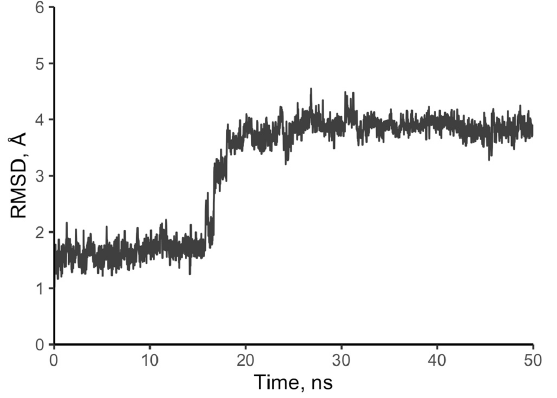
Figure 12. ( a ) Root-mean-square deviation (RMSD) and distance between the M β CD and 2b centers of geometry (Type I complex). ( b ) Type I complex structure.